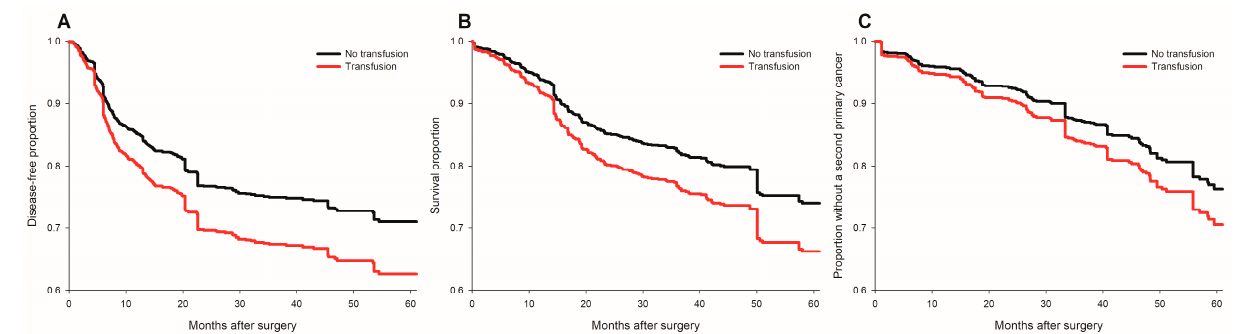
Figure 2. Survival plots of cancer recurrence, all-cause mortality and occurrence of second primary cancers for transfused and non-transfused patients after IPTW. ( A ) cancer recurrence; ( B ) all-cause mortality; ( C ) occurrence of a second primary cancer. No transfusion group (black line); transfusion group (red line).